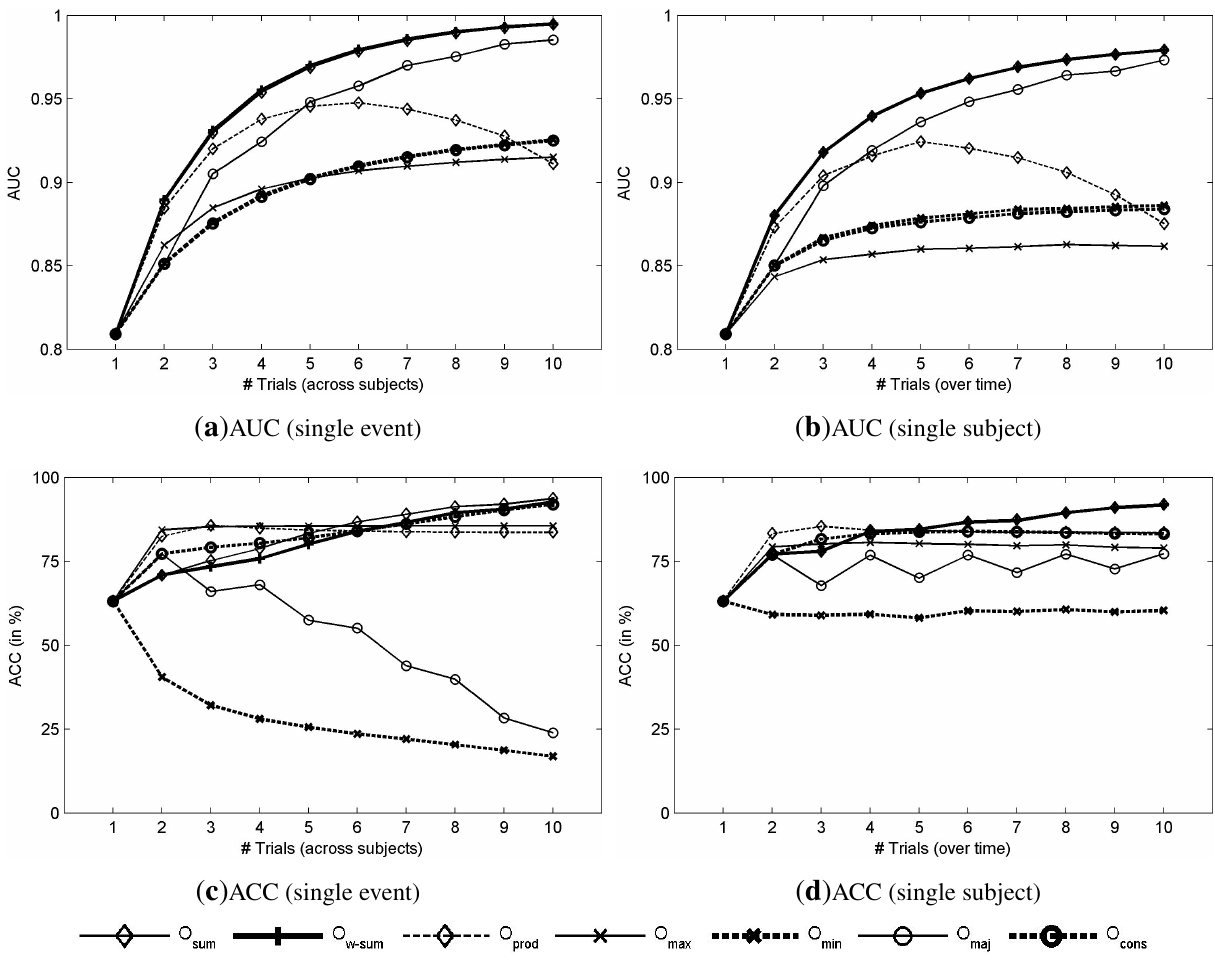
Figure 3. Detection results based on the AUC and the accuracy (ACC). ( a , b ) AUC for single-event detection as a function of the number of subjects, and AUC for a single subject as a function of the number of trials, respectively. ( c , d ) Accuracy for single-event detection as a function of the number of subjects, and accuracy for a single subject as a function of the number of trials,